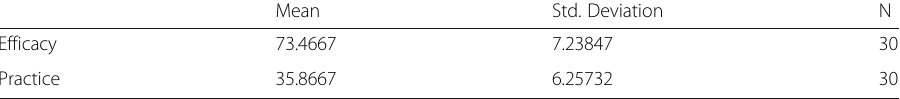
Table 5 Descriptive Statistics for Soft Discipline Teachers ’ Self-efficacy and Instructional